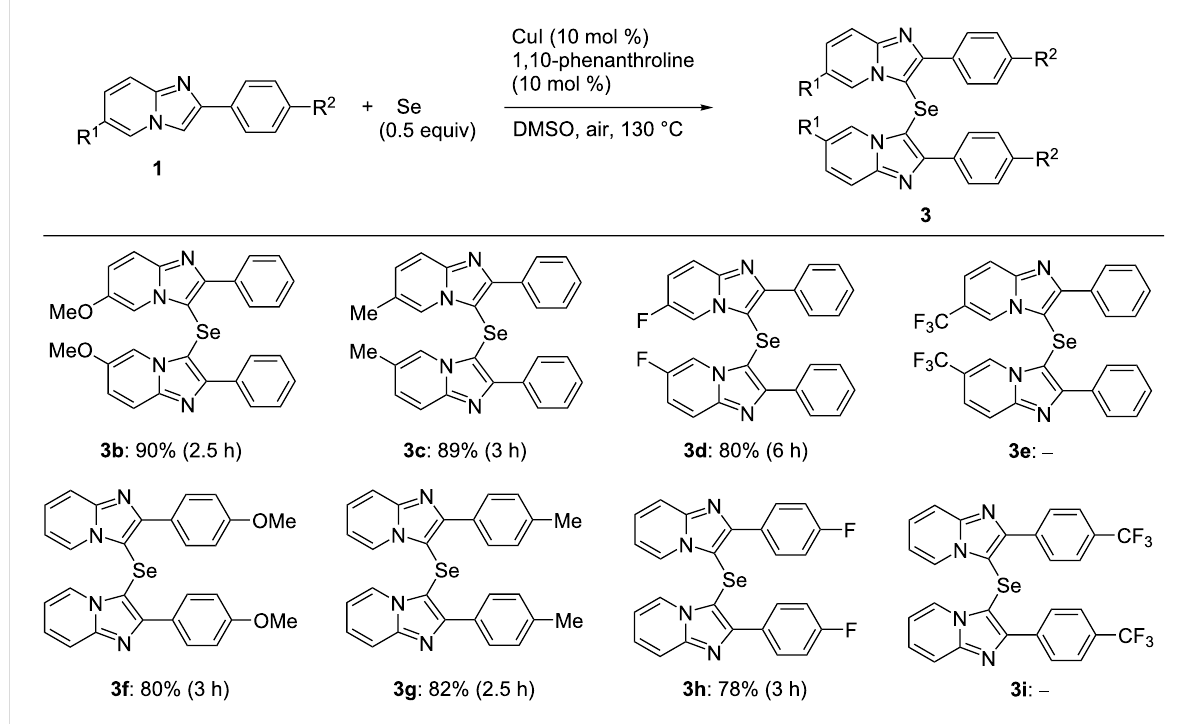
and the selenide 3a are interconvertible in the presence of the imidazopyridine 1a and Se powder. On the other hand, the reac- tion of the imidazopyridine 1a with 1 equiv of Se powder in the presence of 2 equiv of 1,1-diphenylethylene as a radical scav- enger gave the diselenide 2a in a satisfactory yield (78%, reac- tion iv, Scheme 1): only 2a was isolated in 72% yield even when 0.5 equiv of Se powder was